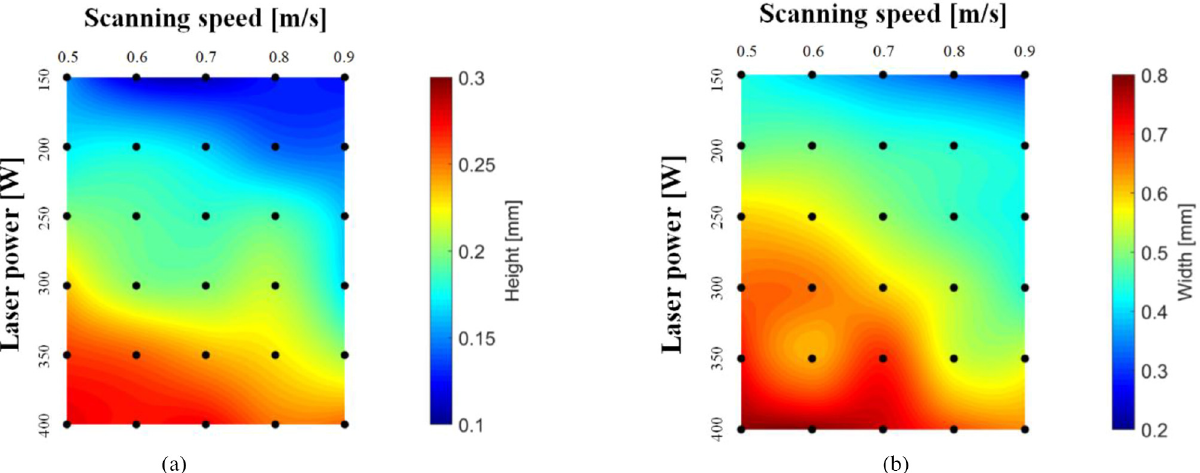
Fig. 10. (a) Corner height contour plot with laser power and scanning speed as process variables and (b) side width contour plot with laser power and scanning speed as process